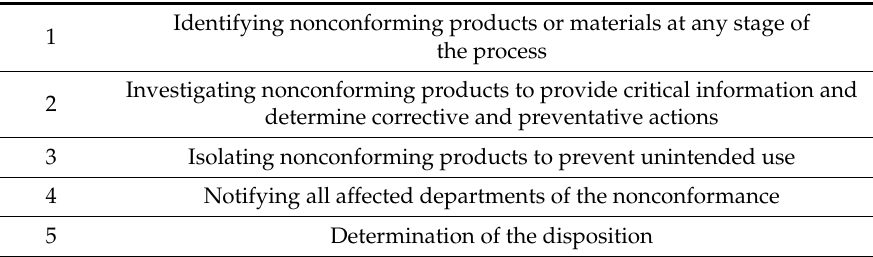
Table 3. Steps required for managing off-specification